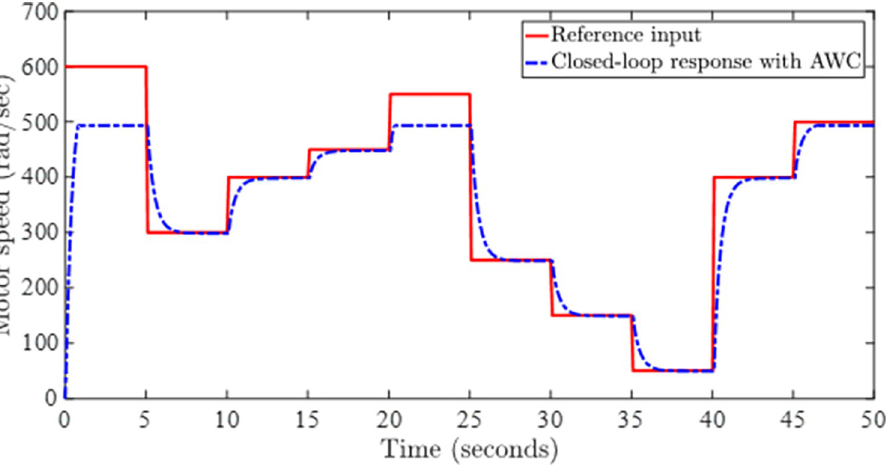
Fig 5. Closed-loop response with